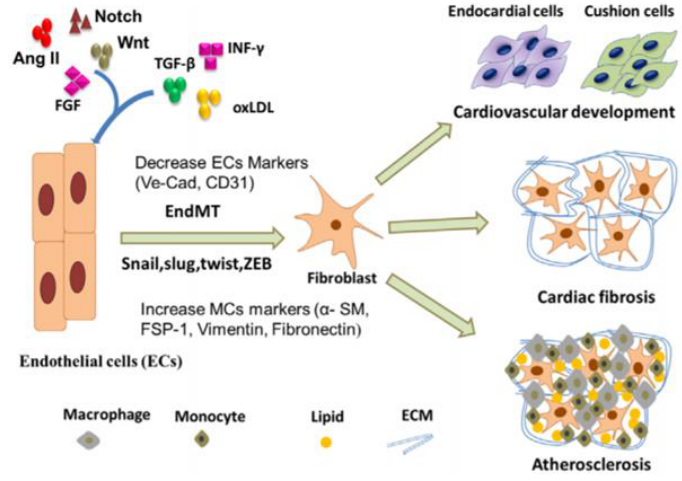
Figure 9. The process of endothelial cells (ECs) differentiating into fibroblasts, leading to cardiovascular development, cardiac fibrosis, or atherosclerosis [124].